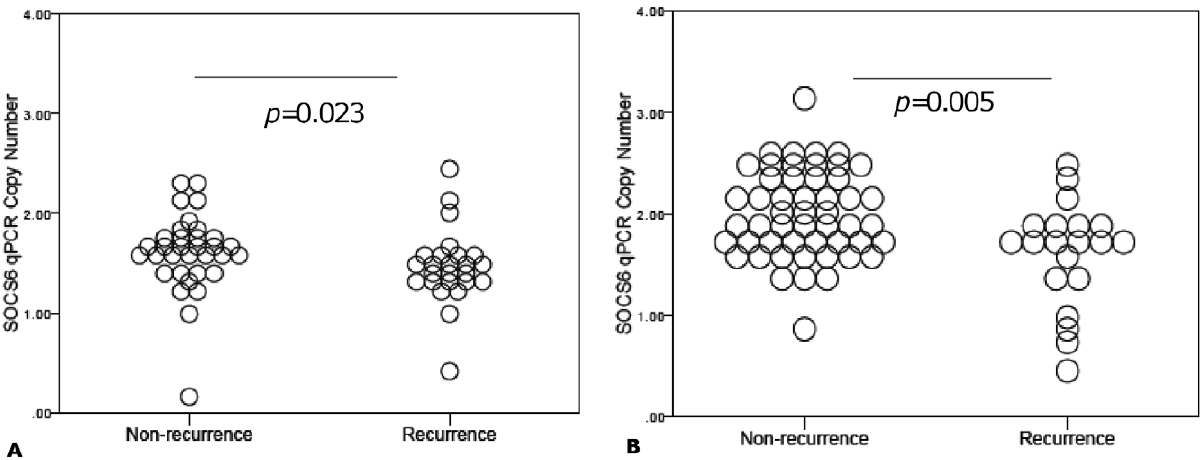
Figure 4. Dot plot of qPCR-derived SOCS6 copy number (y-axis) is compared to the recurrence phenotype (x-axis) in the training (n=62) and test set (n=72) subjects. Figure 4A and 4B represent training set and test set subjects respectively. Mann-Whitney U test to was used to assess for any differences in copy number between recurrence phenotypes and p values , 0.05 were deemed significant.